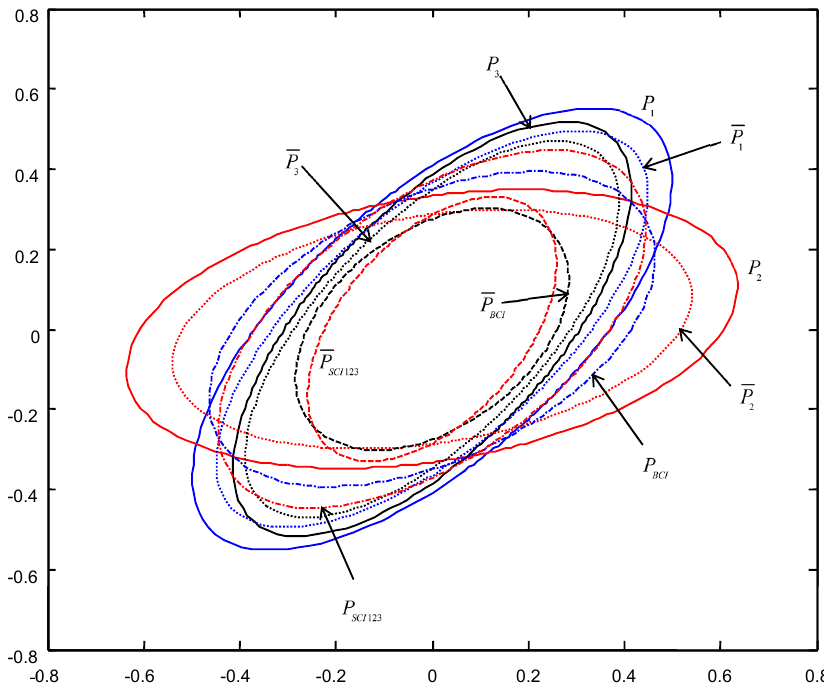
Figure 5. The ellipses of the actual and conservative steady-state filtering error variances of the order SCI